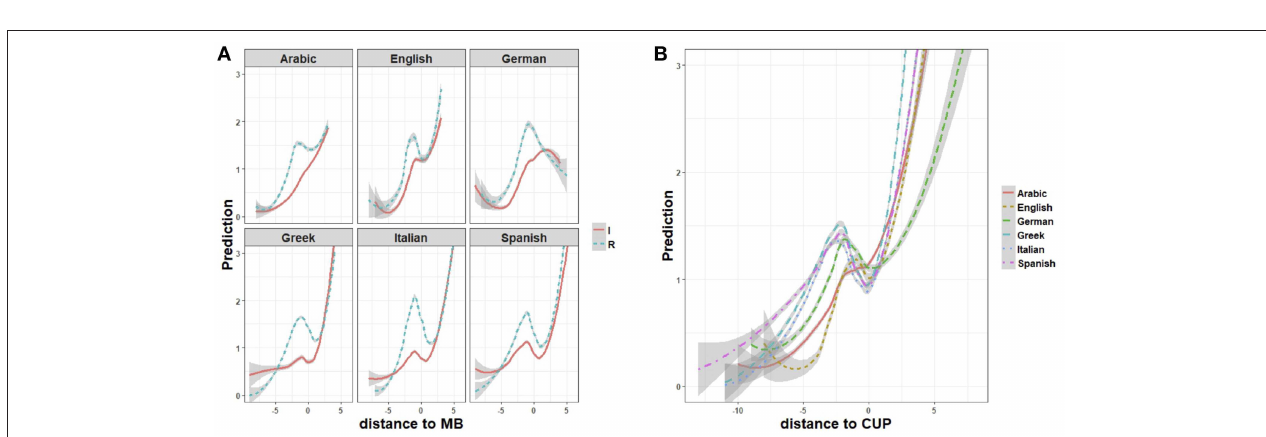
FIGURE 5 | Regression plots ( ggplot2 ) of interaction effects (A) between regularly (cyan lines) and irregularly (red lines) inflected forms and the distance to stem-suffix boundary ( distance to MB ), and (B) between sample languages and the distance to the Complex Uniqueness Point ( distance to CUP =0), in non-linear models ( GAMs ) fitting the processing prediction rate. Shaded areas indicate 95% confidence